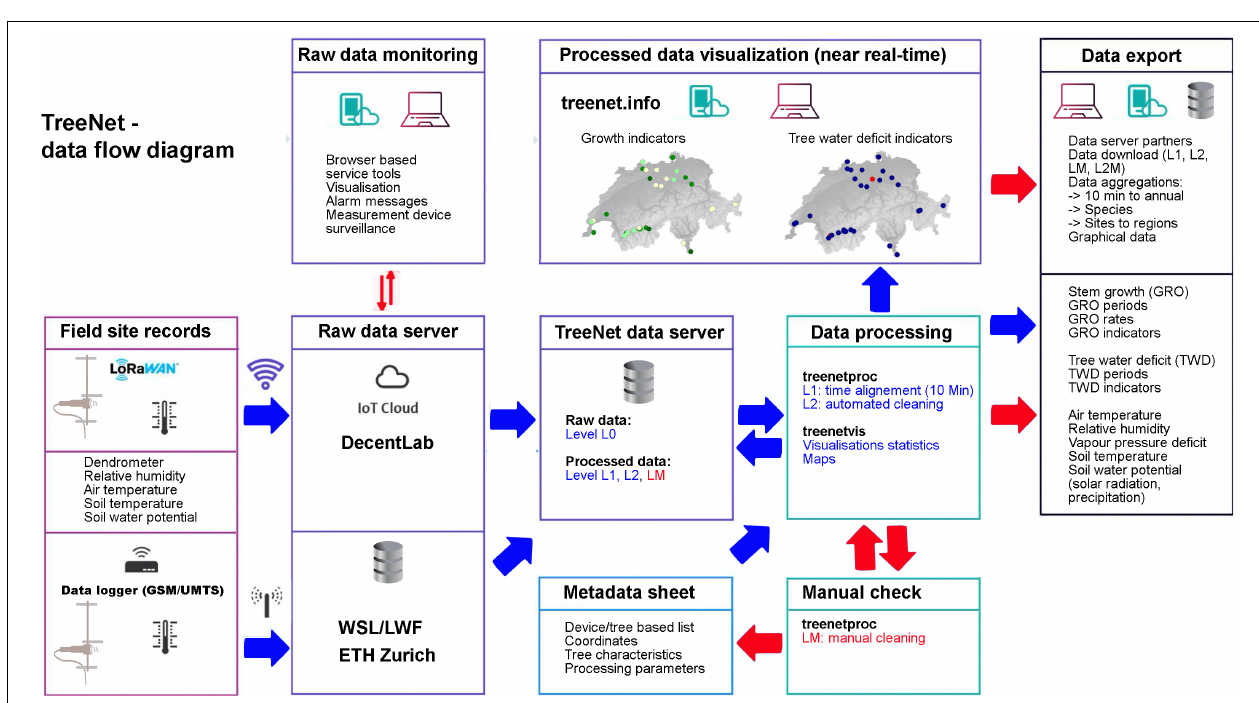
FIGURE 2 | Key measurement devices used in TreeNet. Point dendrometer of the type (a) ZN11-T-IP (Natkon) and (b) ZN12-T-WP (Natkon) are mounted to the stem with three stainless steel rods anchored 5–10 cm in the stem wood at about 1.5 m height, (c) air temperature and relative humidity (RHT, Sensirion) are recorded in a weather shield at 2 m height in the forest stand or in a nearby located meteorological station. (d) The combined soil temperature and soil water potential sensors (TEROS21, Metergroup) are located in 10–20 cm soil depth at each site. The TreeNet infrastructure is kept largely harmonized in terms of measurement device types to minimize artifacts caused by different measurement methods.